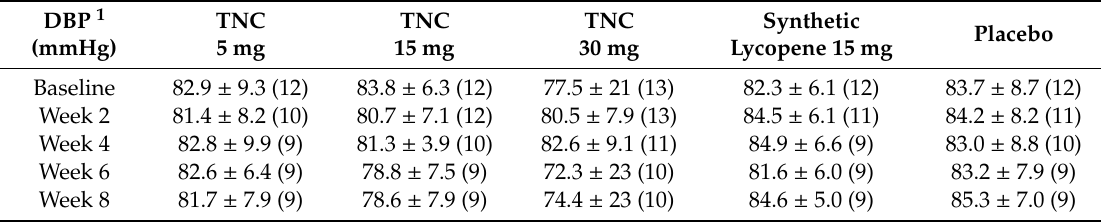
Table 3. DBP during eight weeks of treatment.